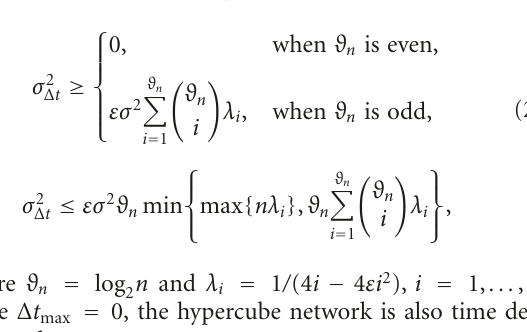
Figure 5: σ 2 as a function of the iteration time index for the DCTS Δ t algorithm in structured networks with Gaussian delay between network nodes.